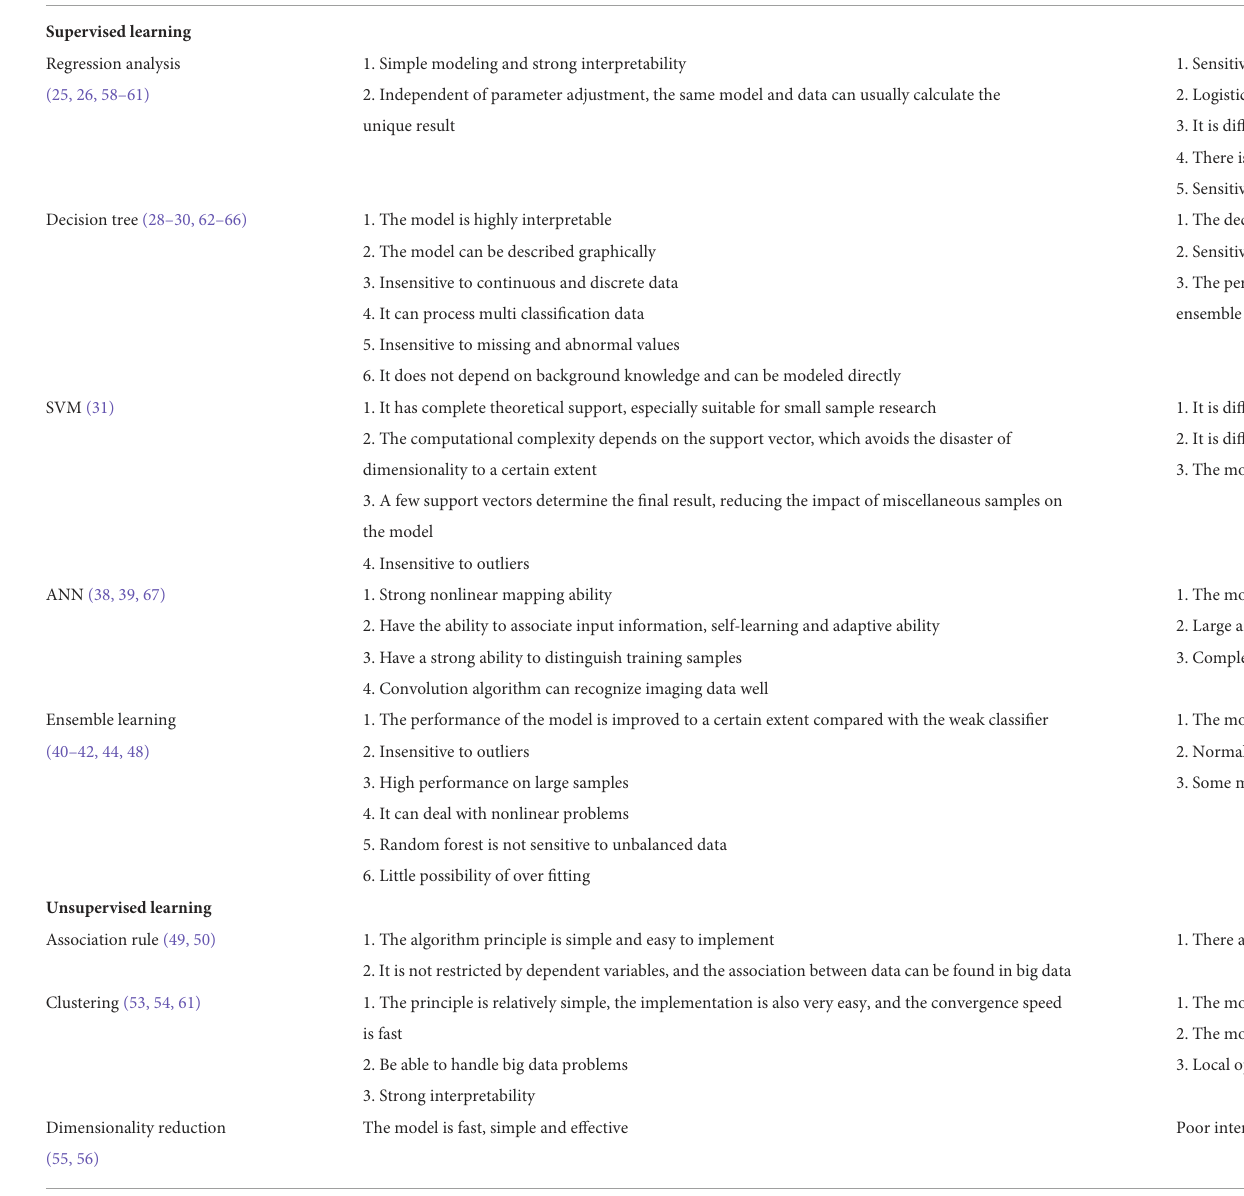
TABLE 1 Advantages and disadvantages of supervised learning and unsupervised learning